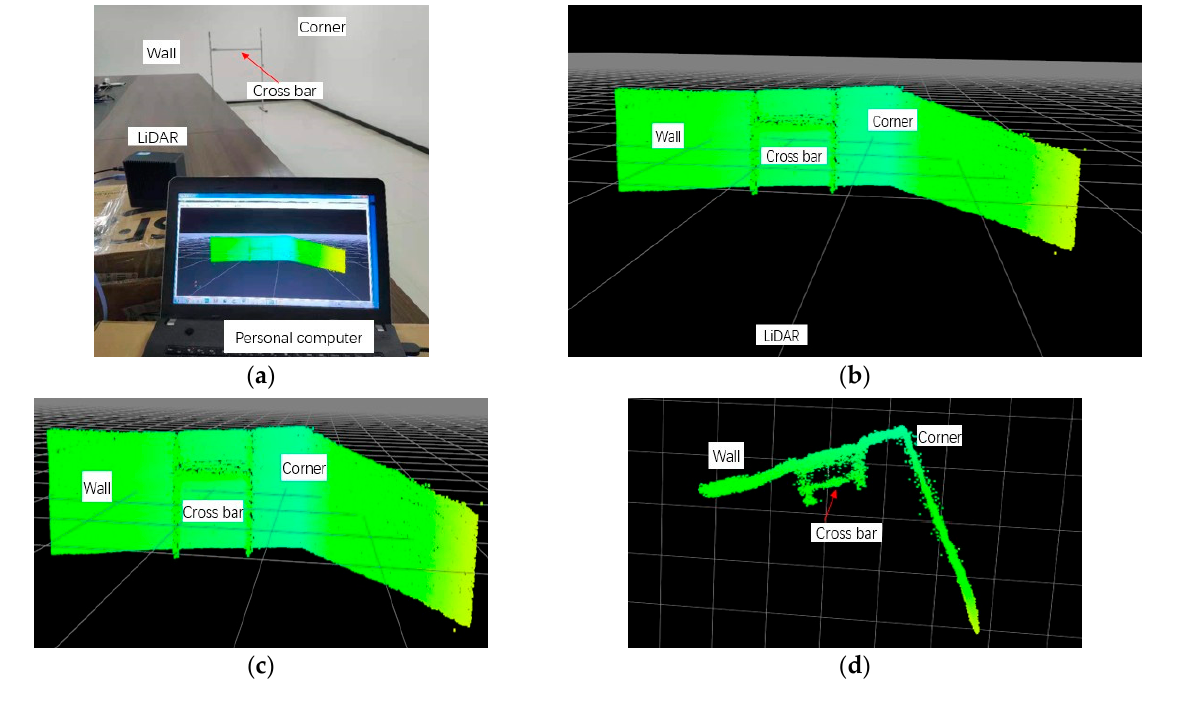
Figure 5. ( a ) Picture of the experiment of the angular resolution of 0.2° × 0.15°, ( b ) panorama of the cloud point, ( c ) front view, and ( d ) top view.